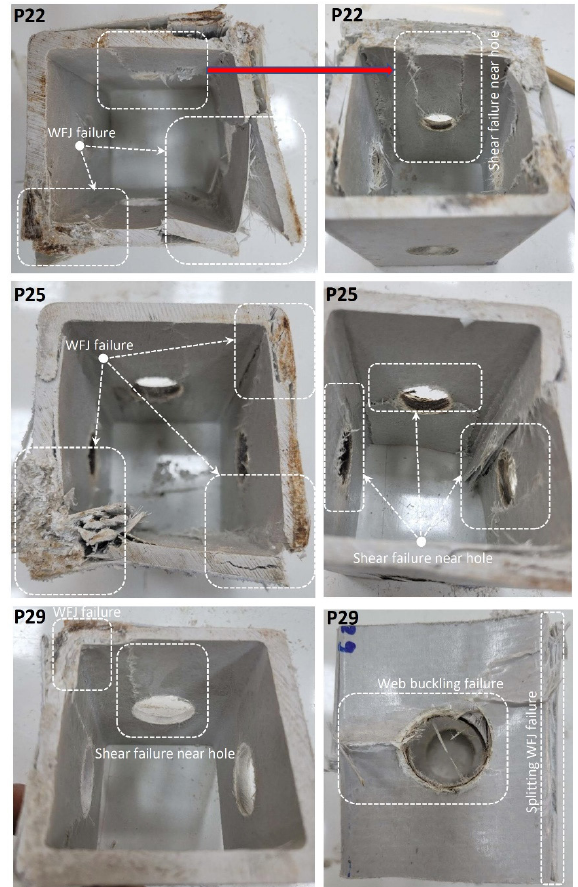
Figure 6. Damage analyses of P22, P25, and P29. Polymers 2022 , 14 , 4095